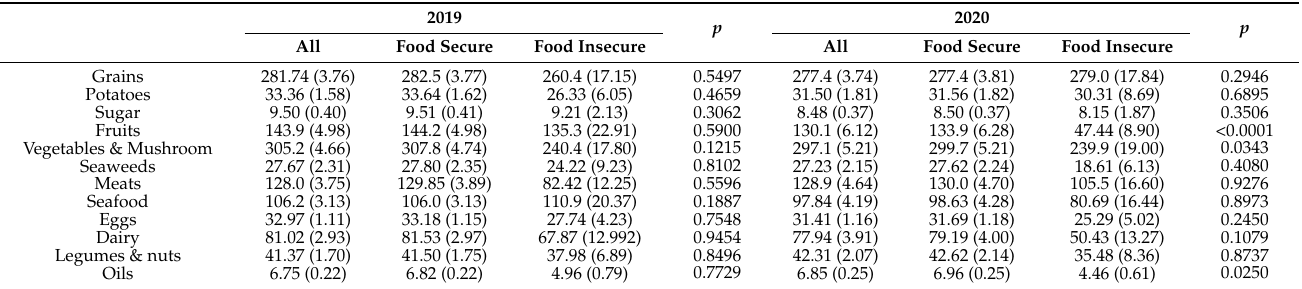
Table 2. Intake level for selected food groups by food security status in 2019 and 2020 (g/day, mean and